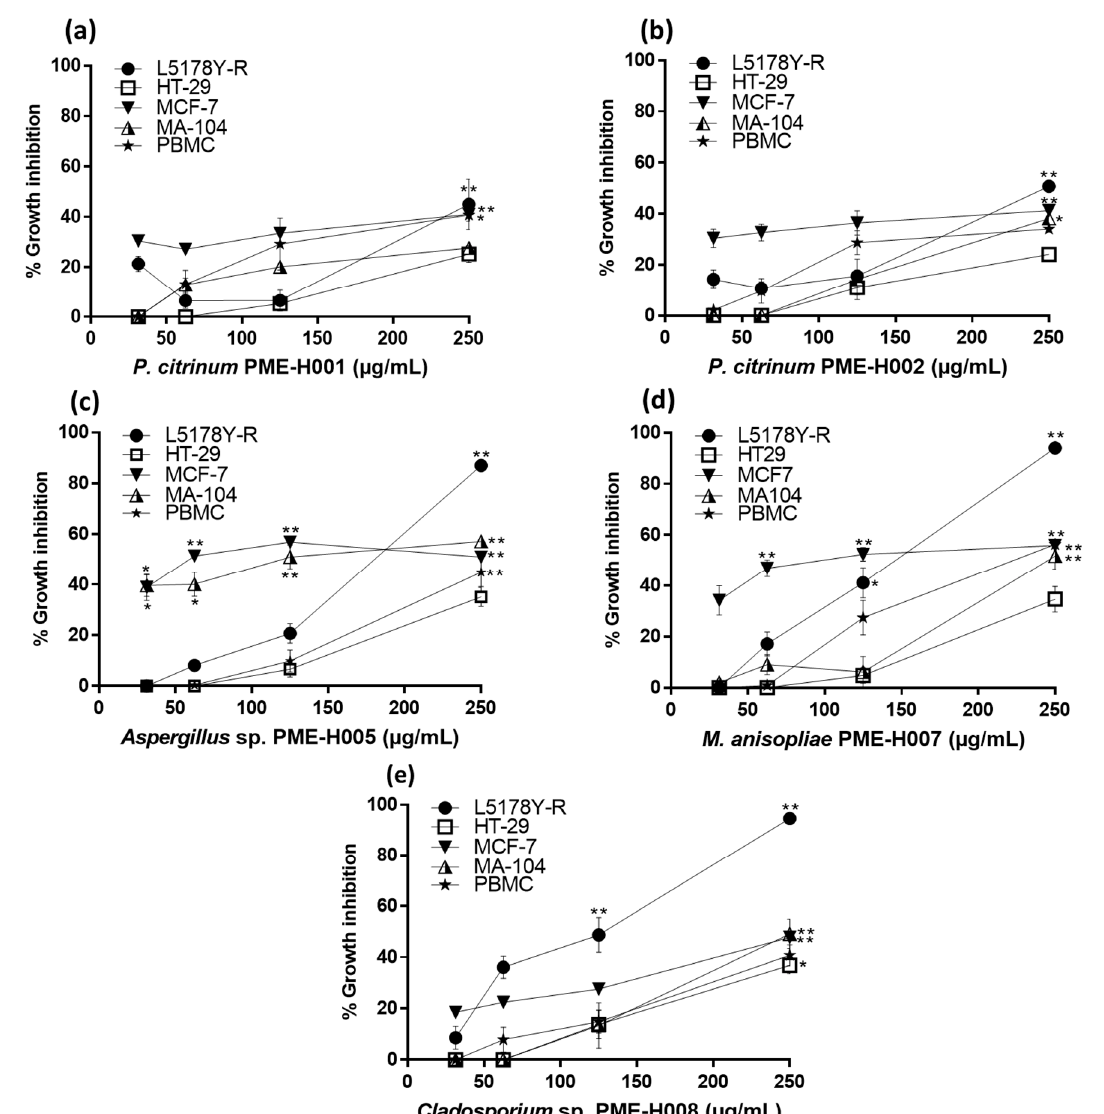
Figure 1. Tumor growth inhibition by L. marginatus endophytic fungus methanol extracts. L5178Y-R, HT-29, MCF-7, and MA-104 cells at 1 × 10 4 cells/well and PBMCs at 1 × 10 5 cells/well were incubated for 24 h and treated for 48 with 31 µg/mL to 250 µg/mL of (a) PME-H001, (b) PME-H002, (c) PME-H005, (d) PME-H007, and (e) PME-H008 fungus strain methanol extracts, as detailed in the text. Cell growth inhibition was evaluated via the MTT reduction assay and ODs measured at 570 nm, using 0.05 µg/mL vincristine sulphate (VC) as a positive control, as detailed in the text. VC caused 77.4%, 46.8%, 14.3%, 24%, and 14.7% cytotoxicity against L5178Y-R, HT-29, MCF-7, MA-104, and PBMCs, respectively. Data represent mean ± SEM of triplicates from three independent experiments. * P < 0.05; ** P < 0.01, as compared with untreated control. OD for untreated control was 1.39 ± 0.12. Table 2 . IC 50a and SI of tumor cell lines and MA-104 and PBMCs treated with fungus methanol extracts. Isolate Code.